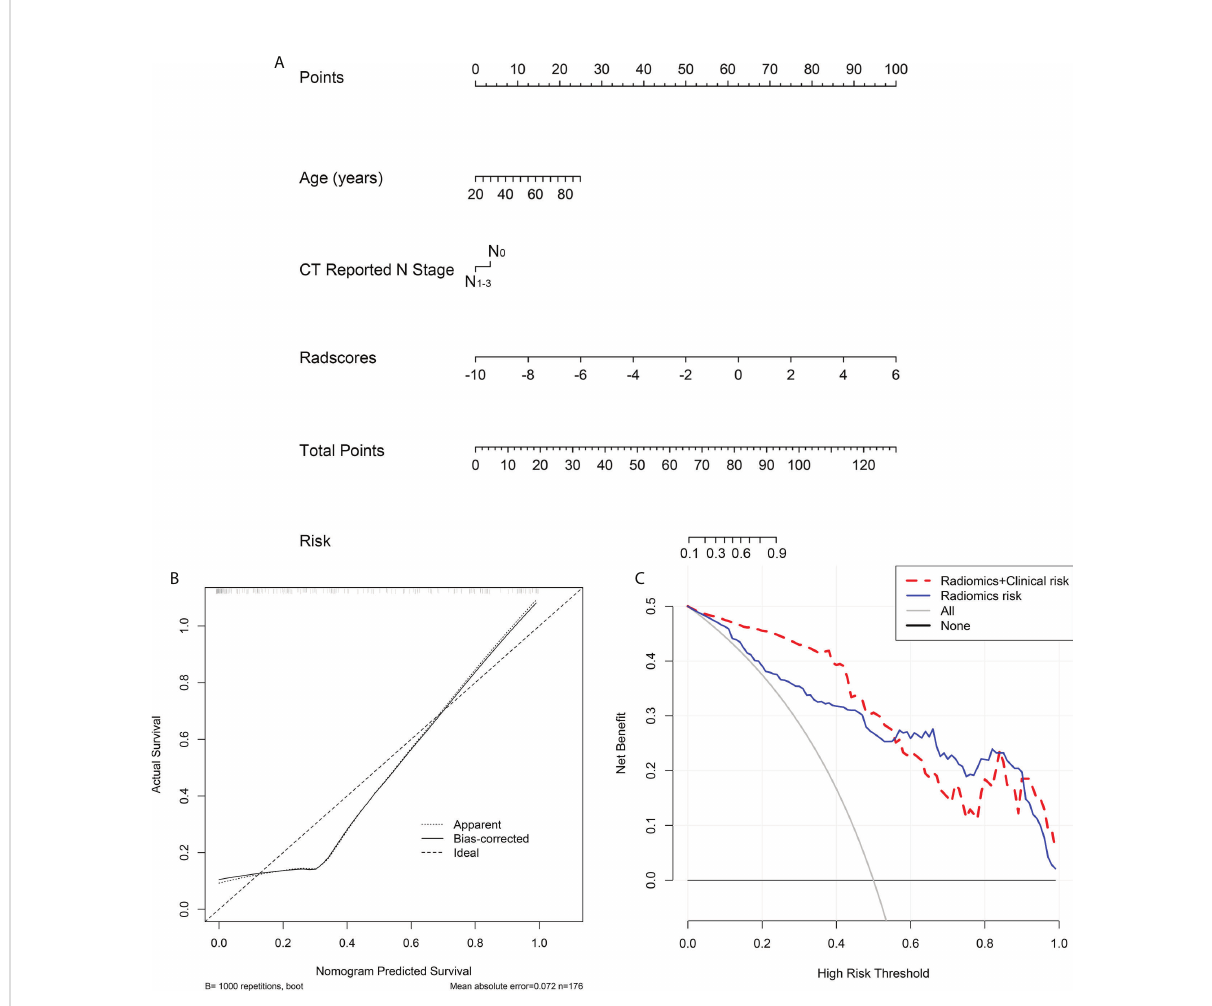
FIGURE 6 Radiomics nomogram developed with ROC, calibration curves, and decision curve analysis (DCA). (A) A radiomic nomogram was constructed in the training cohort via radiomic signature, age and CT reported N stage. (B) Calibration curve of the radiomic nomogram in the training cohort. (C) DCAs for radiomic nomogram and signature in the training